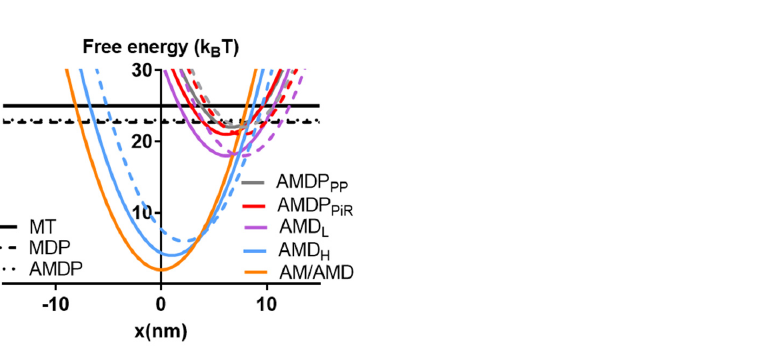
Figure 5. Changes in minimum value and position of free energy diagrams in optimized model . In the optimized model, we assumed different values than in Tables 1 and 2 for the attachment rate constant ( k on ’ = 325 s − 1 ), but also (as indicated by the dashed curves) for the variables x 1 (0 nm), x 11 (0 nm), x 2 ( − 5.5 nm), Δ G AMDL-AMDH = 12 k B T, and Δ G AMDH-AM/AMD = 4 k B T. The free energy diagrams with the standard parameter values are shown by full lines.